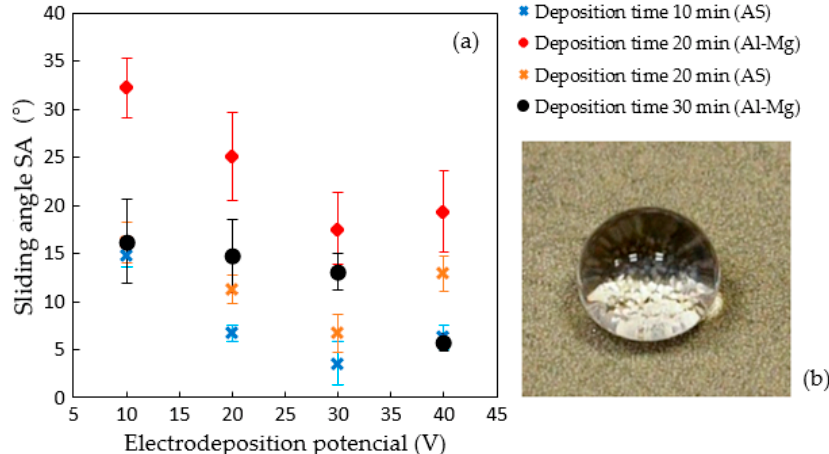
Figure 4. ( a ) Sliding angle (SA) of 50 µL water drops on Al-Mg and AS substrates subjected to electrodeposition with cerium chloride and myristic acid at different voltages (0.3 mA/cm 2 ) for 10, 20, and 30 min. ( b ) Image of water drop placed on a treated AS substrate (30 V and 10 min).